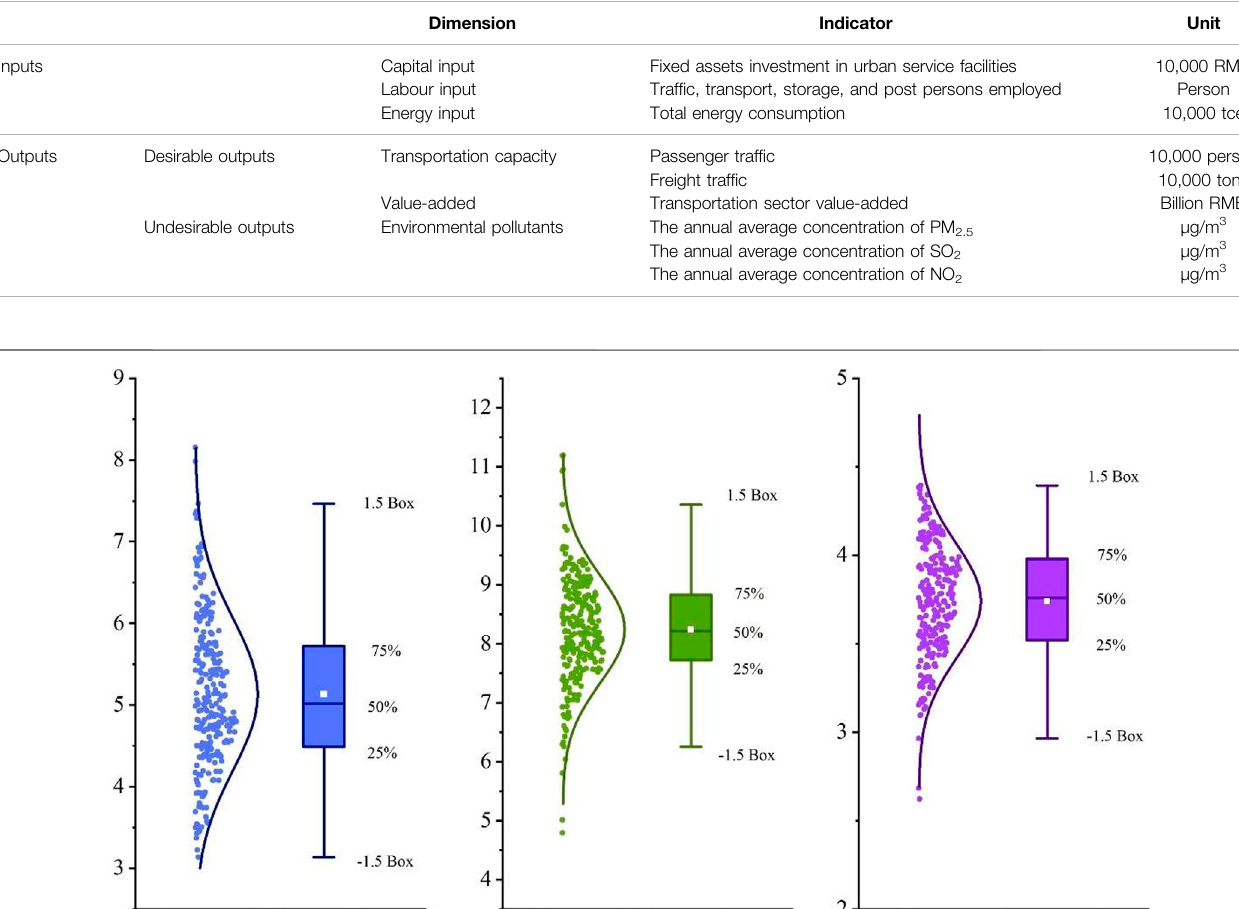
Frontiers in Environmental Science |